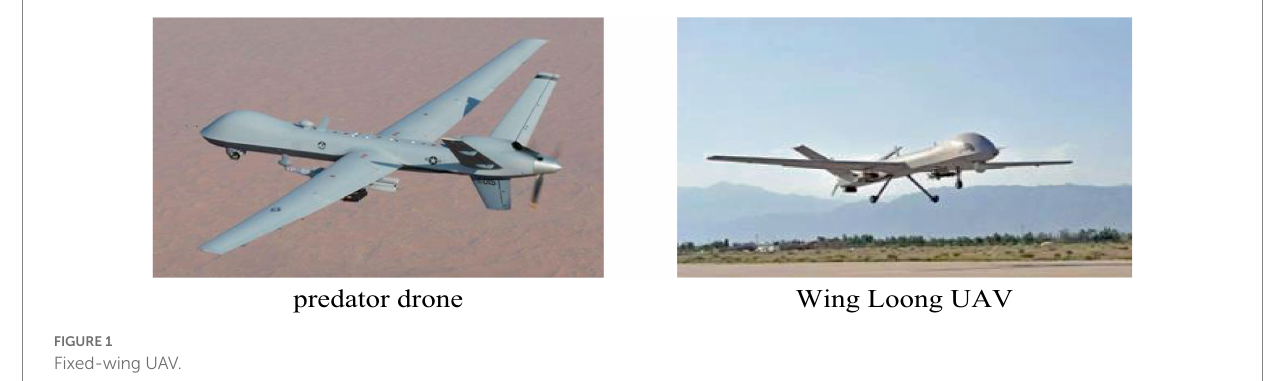
FIGURE 1 Fixed-wing UAV.